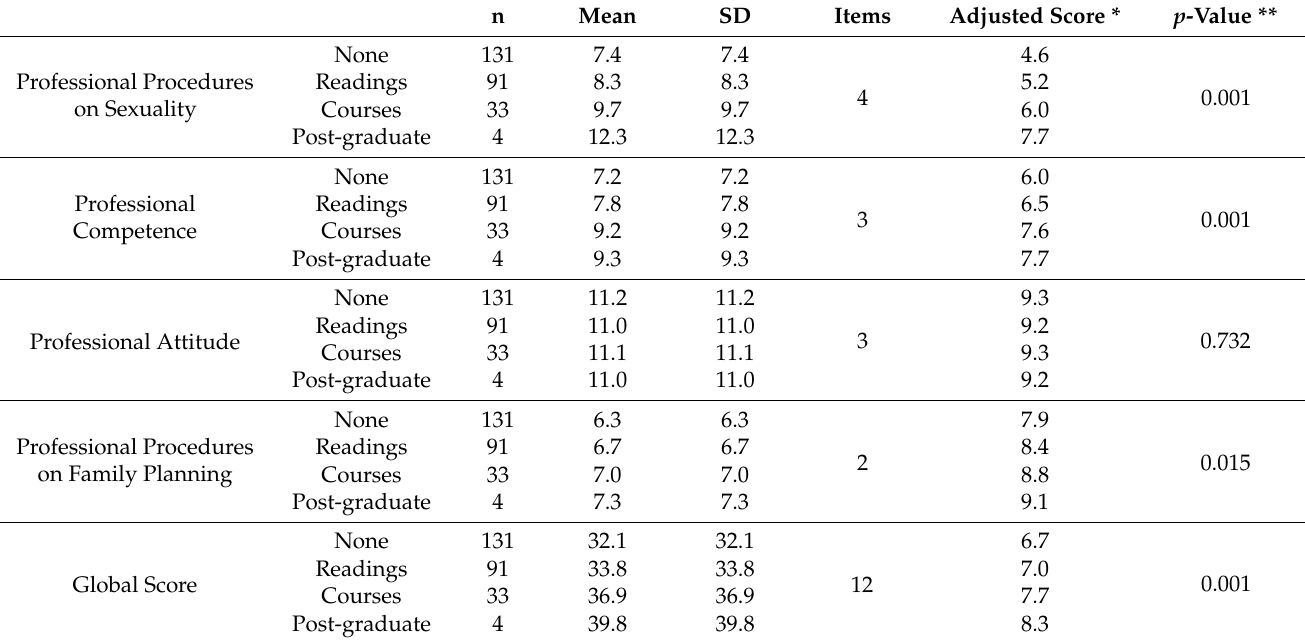
Table 14. Scores regarding sexology training of the